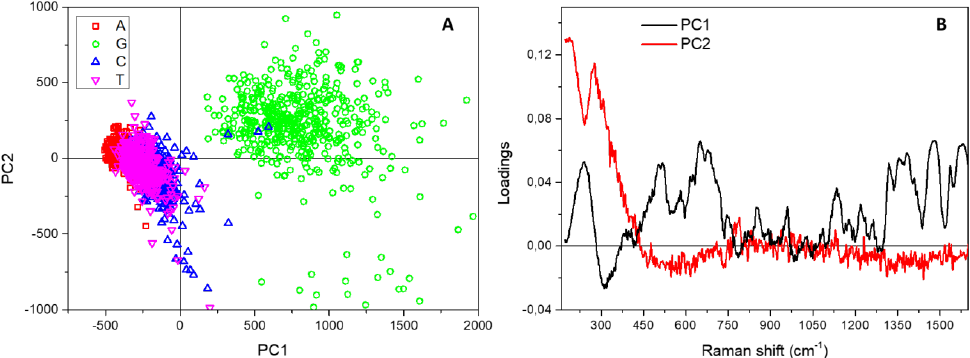
Figure 4. (A ) Score plot resulting from the Principal Component Analysis performed on the spectra composing the Raman map acquired on adenine (red squares), cytosine (blue circles), guanine (green upward triangles) and thymine (magenta downward triangles) samples. ( B ) Spectral loadings corresponding to the first two principal components.